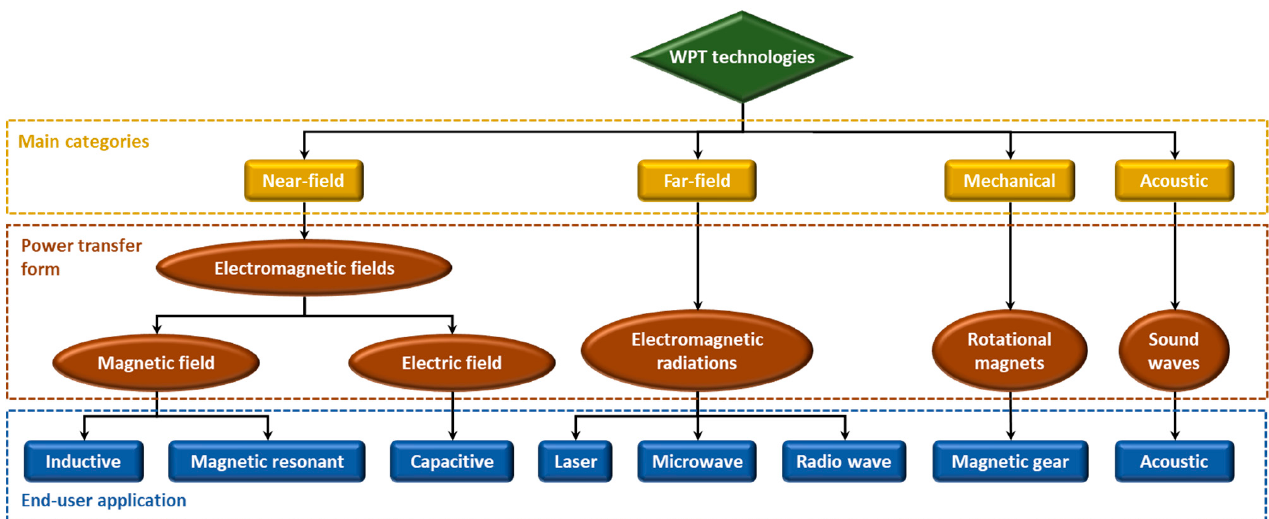
Figure 18. The categories of WPT technologies for EV applications.